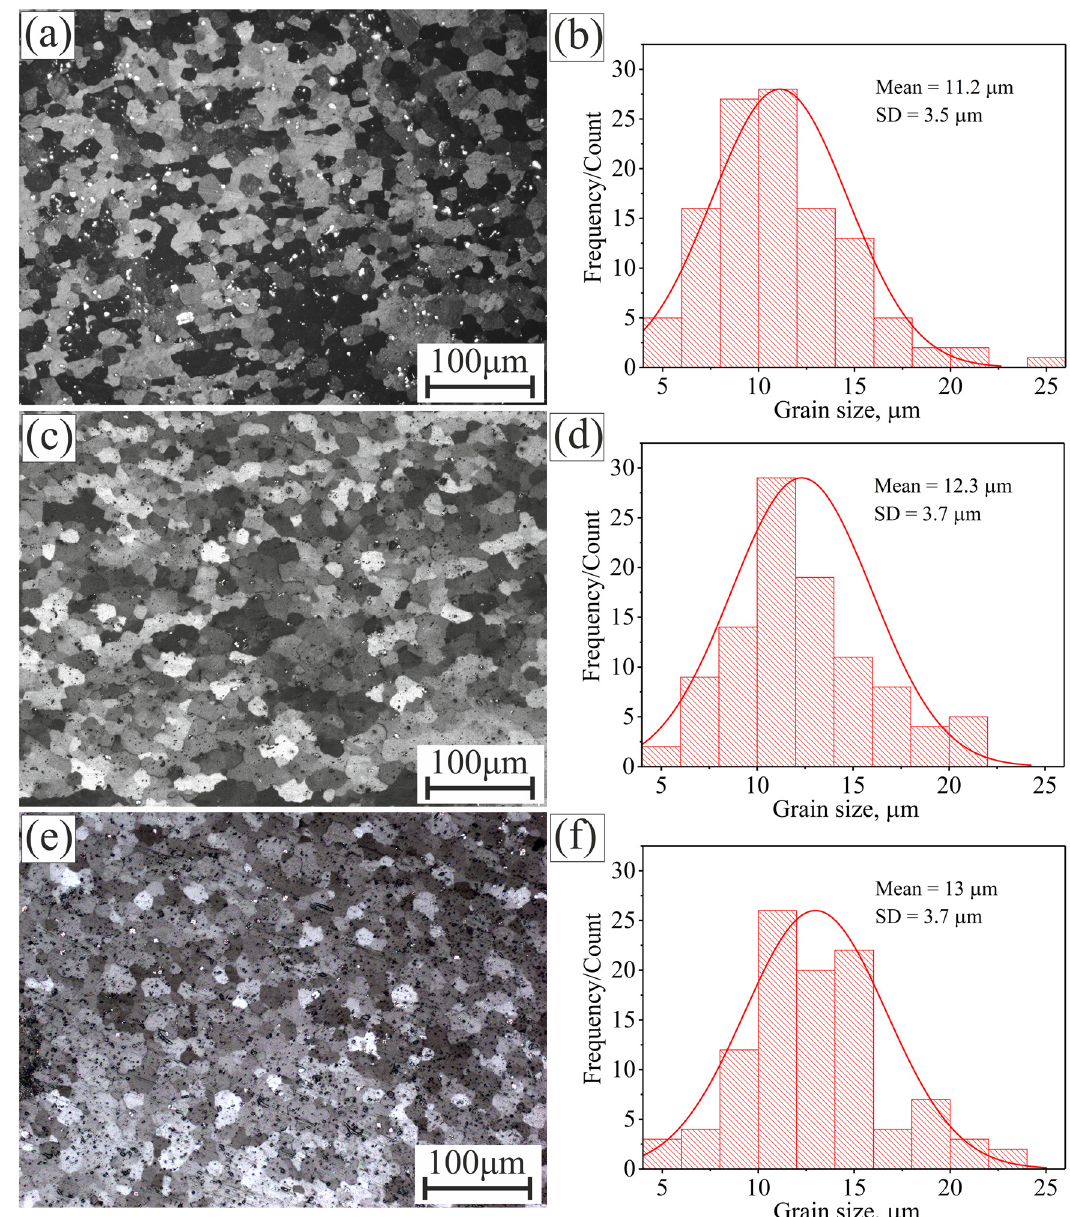
Figure 4: Microstructure and frequency distribution of the grain size of the matrix alloy reinforced with ( a and b ) mono GNPs, ( c and d ) mono BN nanoparticles, and ( e and f ) hybrid of BN nanoparticles and